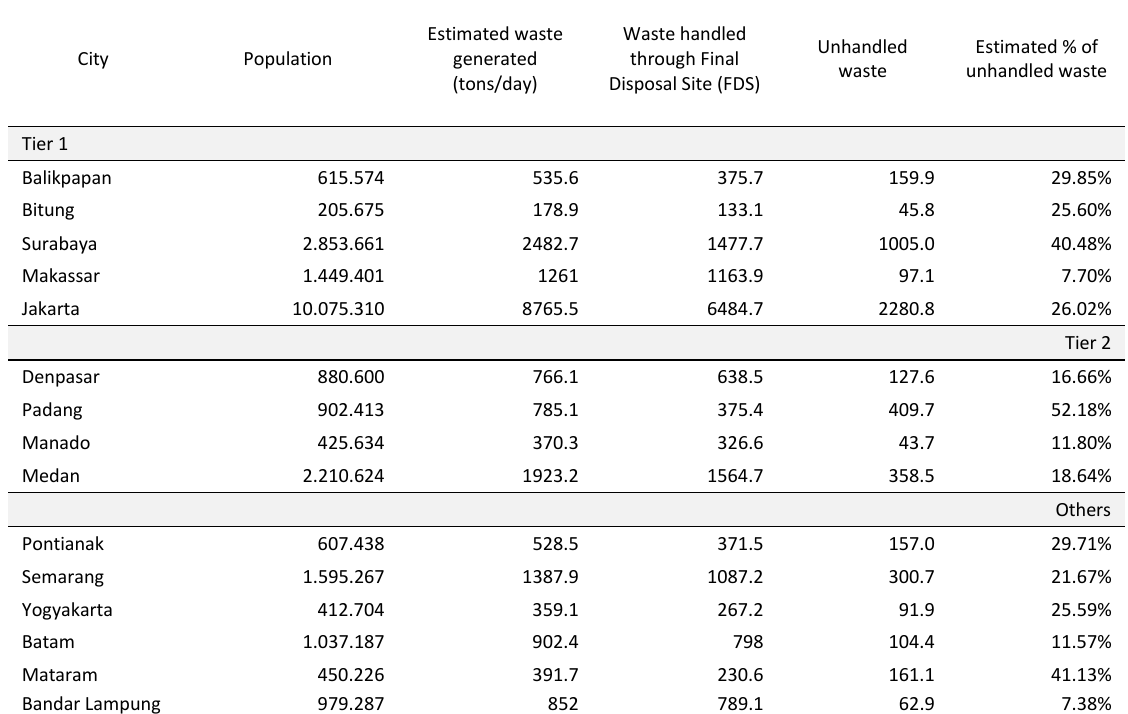
Table 1: Estimated waste generation from 15 large cities in Indonesia (Shuker and Cadman, 2018)